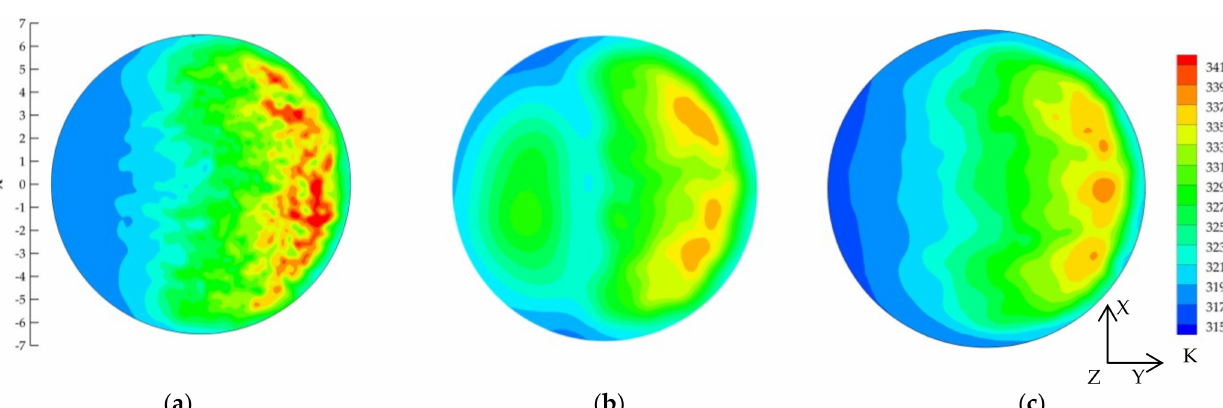
Figure 10. Distribution of flue gas temperature at different height Z: ( a ) OST; ( b ) DST; ( c ) RBST. Figure 11 is the distribution of flue gas temperature at Z = 8 m plane. In OST, two- phase heat transfer is insufficient while there is higher temperature in part of the flue gas. In DST and RBST, the two-phase heat transfer effect is better, which further verifies the promoting effect of gas-liquid contact intensification on heat transfer.